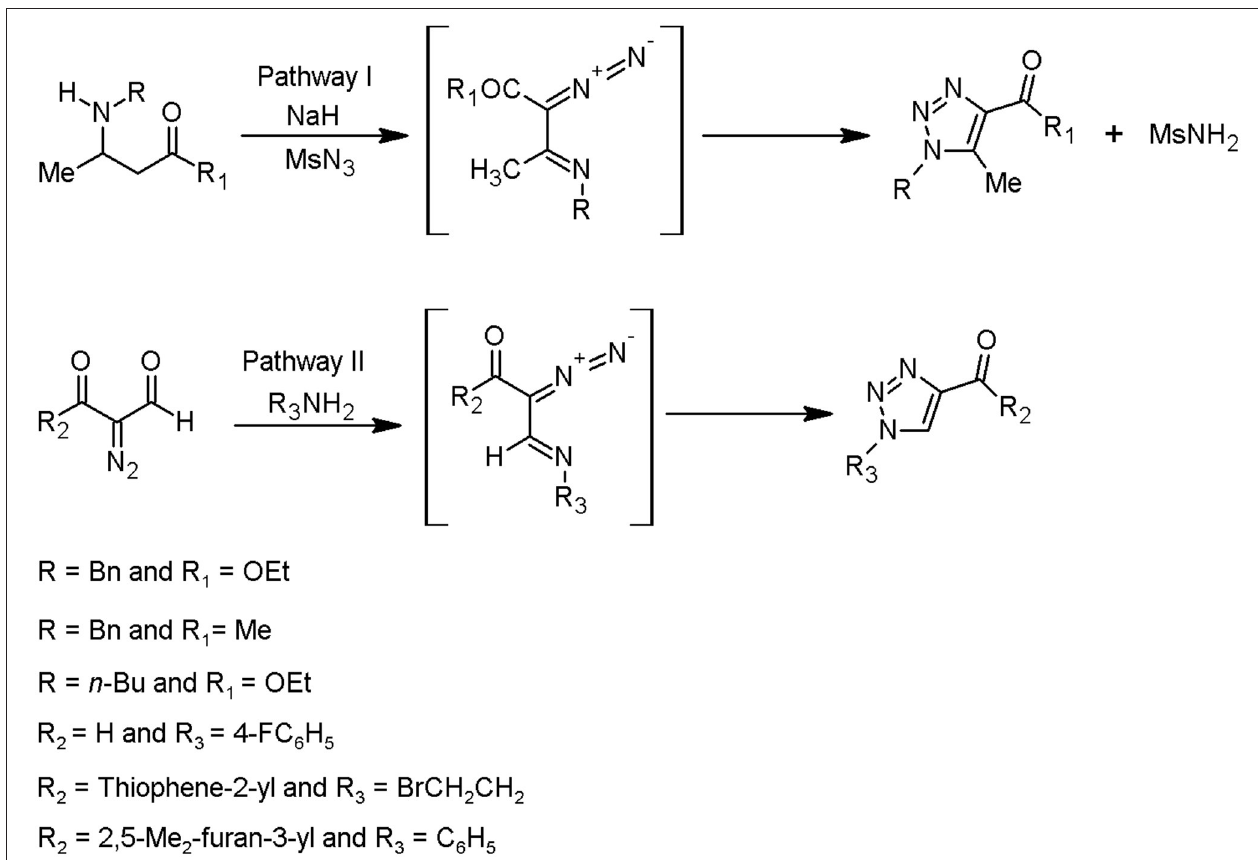
FIGURE 2 | Methods to prepare the triazoles from α -diazoimines (Jordão et al.,